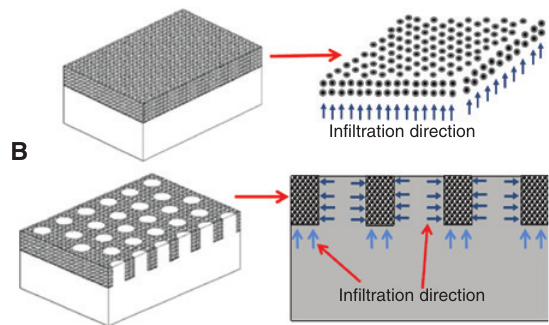
Figure 2: Infiltration casting schematic: (A) layered composites; (B) honeycomb structure composites